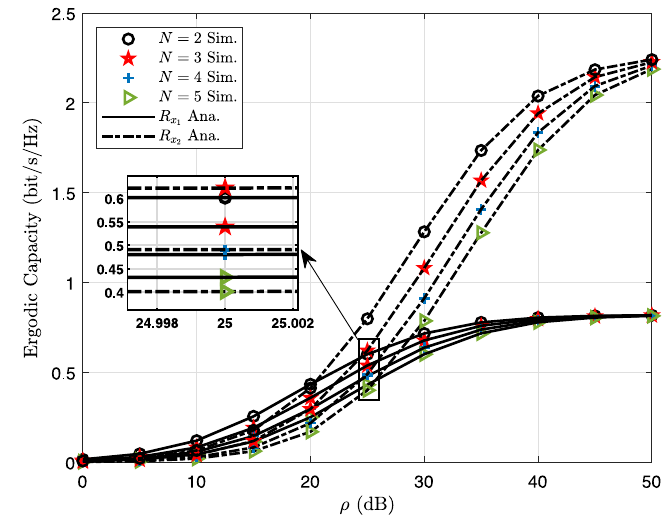
Fig. 8 Ergodic capacity vs ρ (dB) varying N with the satellite link under